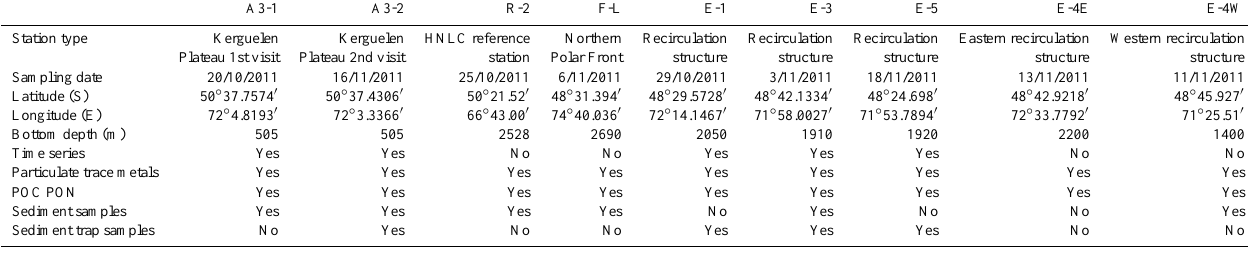
Table 1. KEOPS2 sampling locations and station types.